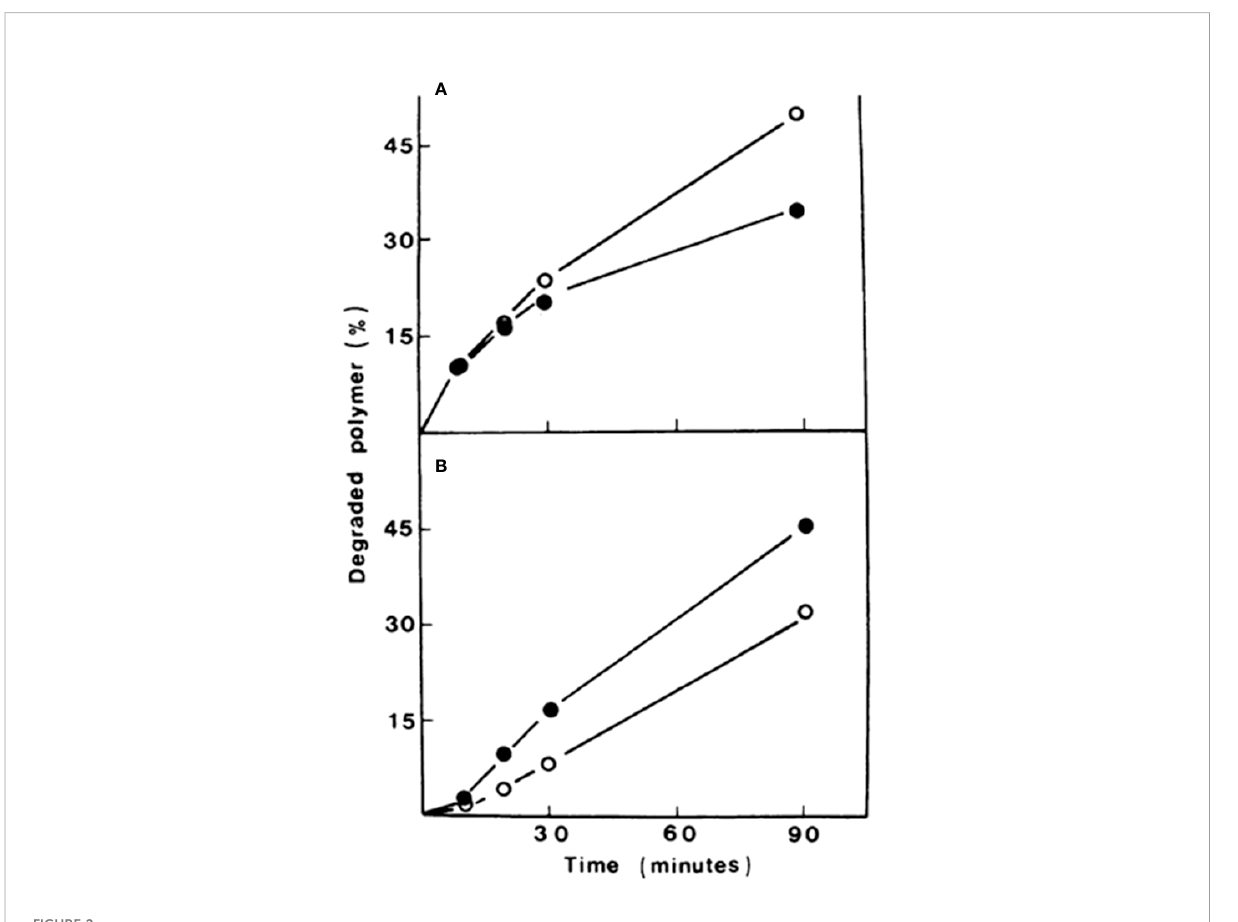
FIGURE 2 Degradation rates of b (1-3)-glucan (A) and chitin (B) synthesized in vitro in the presence (closed circles) or absence (open circles) of Calco fl uor. The initial amount of polysaccharide to be degraded was ca. 260 nmol (ca. 300,000 cpm). Modi fi ed from Roncero and Dura ́ n